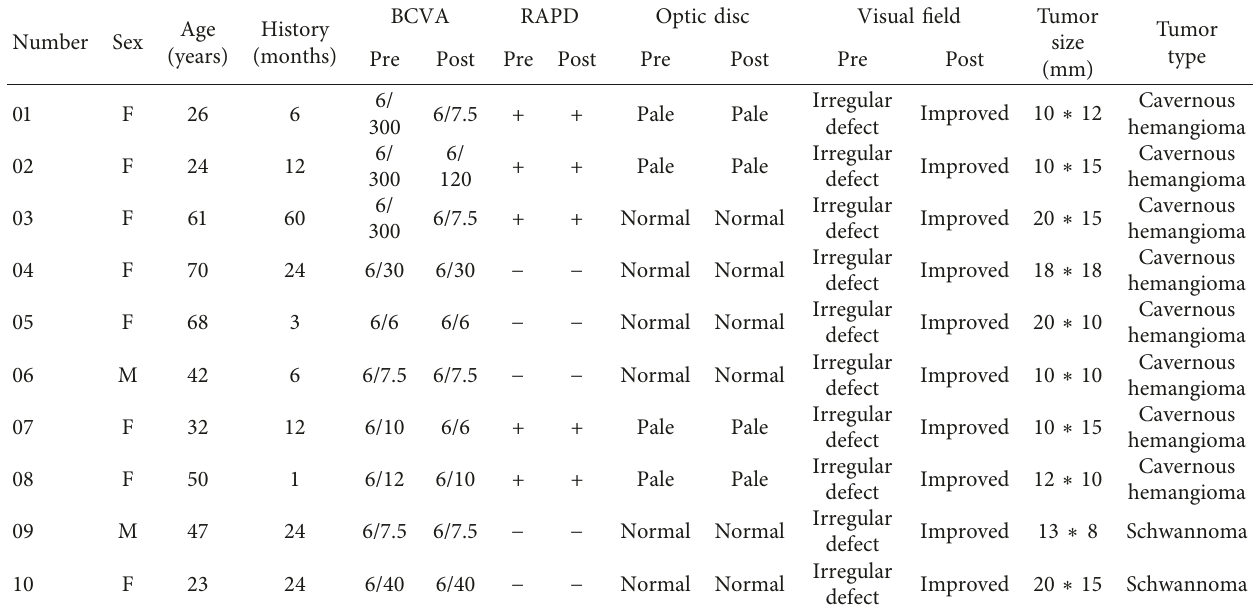
Figure 2: Computed tomography (CT) and magnetic resonance imaging (MRI) of the patient with schwannoma at the apex. (a, b) Orbital CT images showed a suborbicular and well-defined mass with isodensity mass located at the right inferolateral apex. (c) MRI T1-weighted images showed an isointensity mass at the right apex. (d) MRI T2-weighted images showed a high-intensity mass (white Table 1: Clinical date of 10 patients with tumors at the lateral orbital apex.